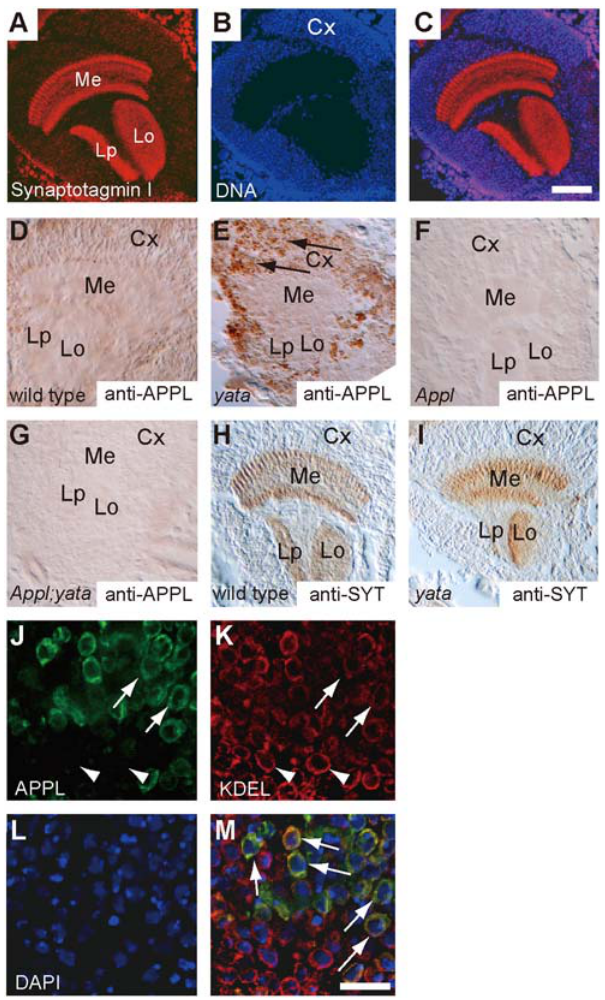
Figure 4. Impaired subcellular localization of endogenous APPL in the yata mutant. (A–C) Sections of the mid-pupal brain were stained with anti-Synaptotagmin I antibody (A) and ToPro3 for nucleic acids (B). Anti-Synaptotagmin I antibody labels synaptic neuropils of medulla (Me), lobula (Lo) and lobula plate (Lp), which are surrounded by cortical regions (Cx) that contain cell bodies. Scale bar: 50 m m. (D–G) Sections of the second-day pupal optic lobe were stained by anti-APPL antibody. In the wild type (D), both cortical regions and neuropils were stained; in the yata mutant (E), intense staining was observed in the cortical regions (arrows). Both Appl (F) and Appl ; yata (G) null mutants showed only background staining. (H, I) Localization of Synaptotagmin I in the wild type (H) and the yata mutant (I). Localization of Synaptotagmin I was not changed in the yata mutant. (J–M) Localization of endogenous APPL in the yata mutant. Immuno- reactivity of APPL (J, green) was observed to surround DAPI-positive nuclei (L, blue) and overlap mostly with staining for anti-KDEL antibody (K, red, arrows in M) that labels the ER. In the areas where APPL was intensely accumulated, the immunoreactivity for the anti-KDEL antibody was often reduced (region indicated by arrows in (J, K), compare with the region indicated by arrowheads). Scale bar: 10 m m. doi:10.1371/journal.pone.0004466.g004 regions were affected is unclear and remains to be elucidated. It is noteworthy that yata mutant optic lobes show reduced volumes at day 0 (M. S., unpublished data), while central brain volumes are normal at day 0. Therefore, the accumulation of Sec23p may be related to the cellular dysfunction caused by the yata mutation, which may eventually result in cell death.